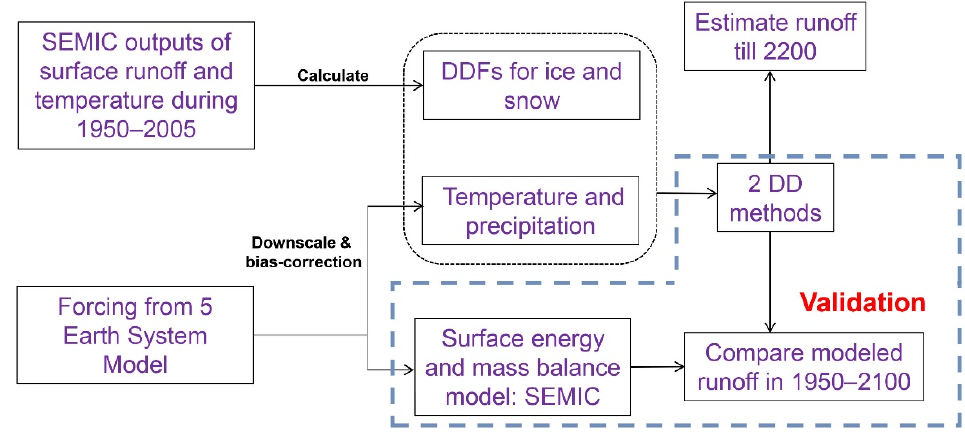
Figure 1. Flow chart of the study design.